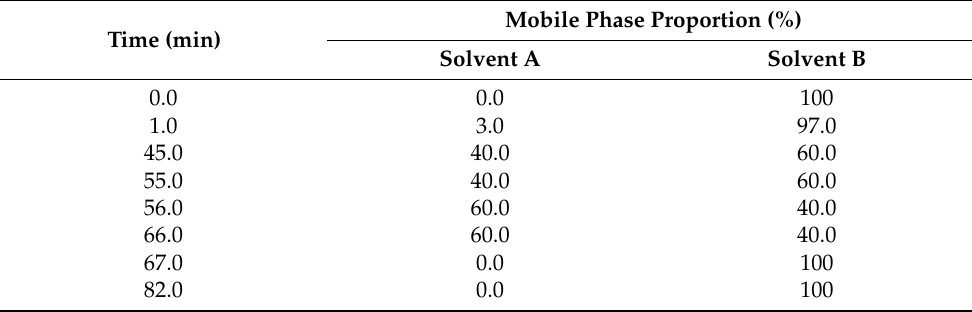
Table 2. Mobile phase gradient for the analytical high-performance liquid chromatography